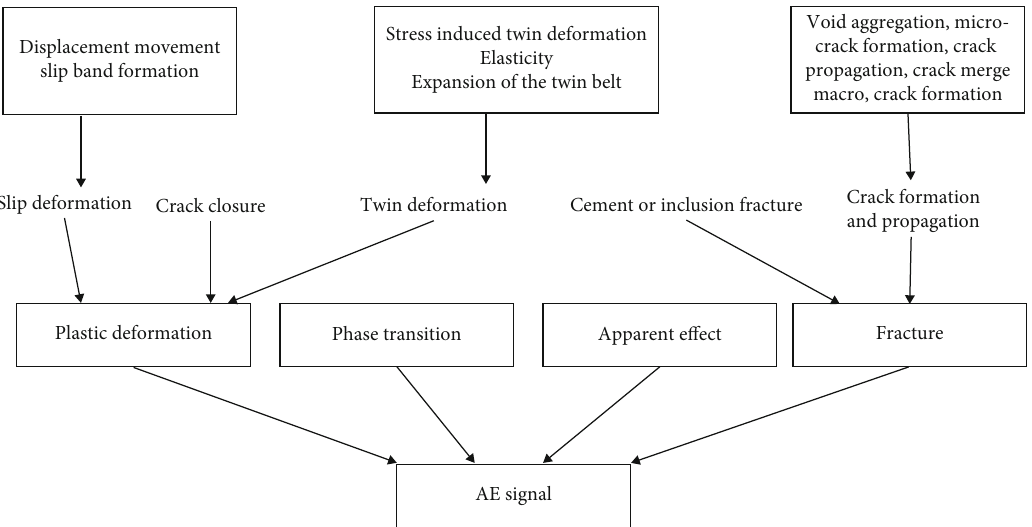
Figure 1: AE (MS) signal generation